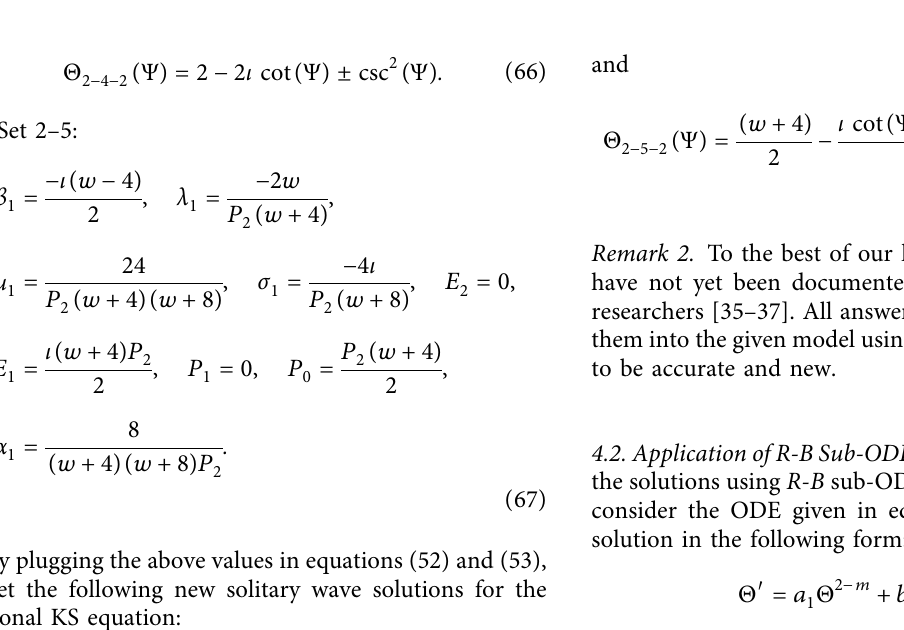
� 0 . 5, and w � 0 . 3. (a) Θ 221 , (b) Θ 222 , (c) Θ 221 , Θ 222 1